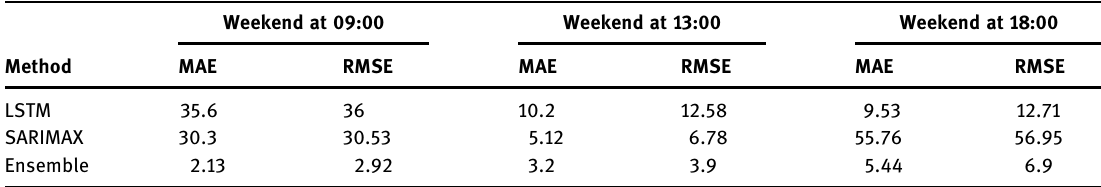
Table 6: Evaluation of algorithms without visitor trend data on